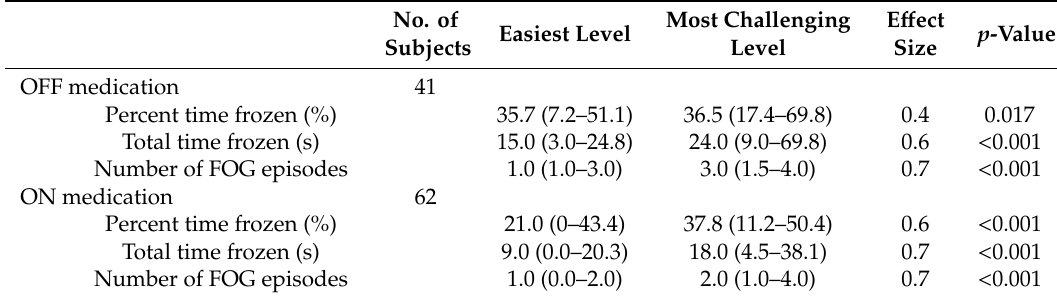
Table 4. FOG outcomes determined by using the automated algorithm di ff er in between the easiest and most challenging levels of the test within OFF–ON states.